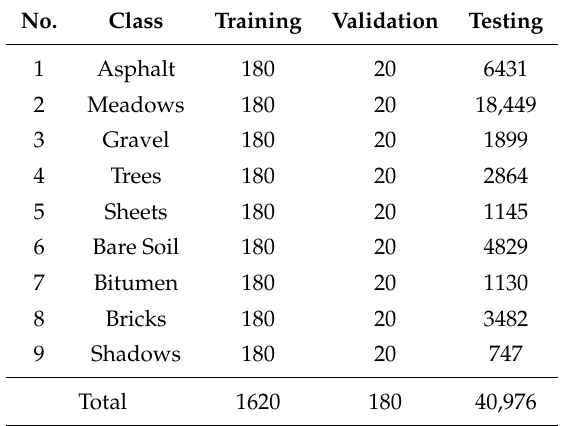
Table 3. Statistics of Training pixels, Validation pixels and Testing pixels for the PaviaU DataSet.